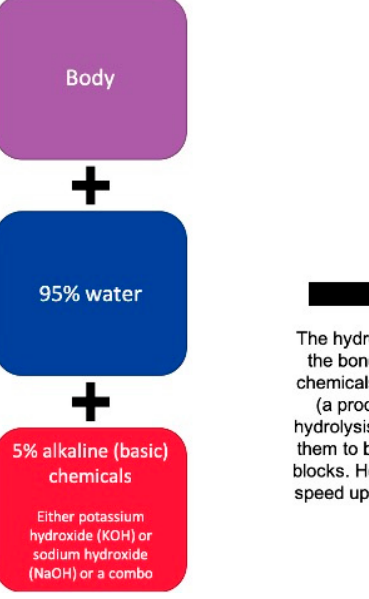
Figure 1. Information graphic summarizing the alkaline hydrolysis process (Cremation Association of North America 2019).